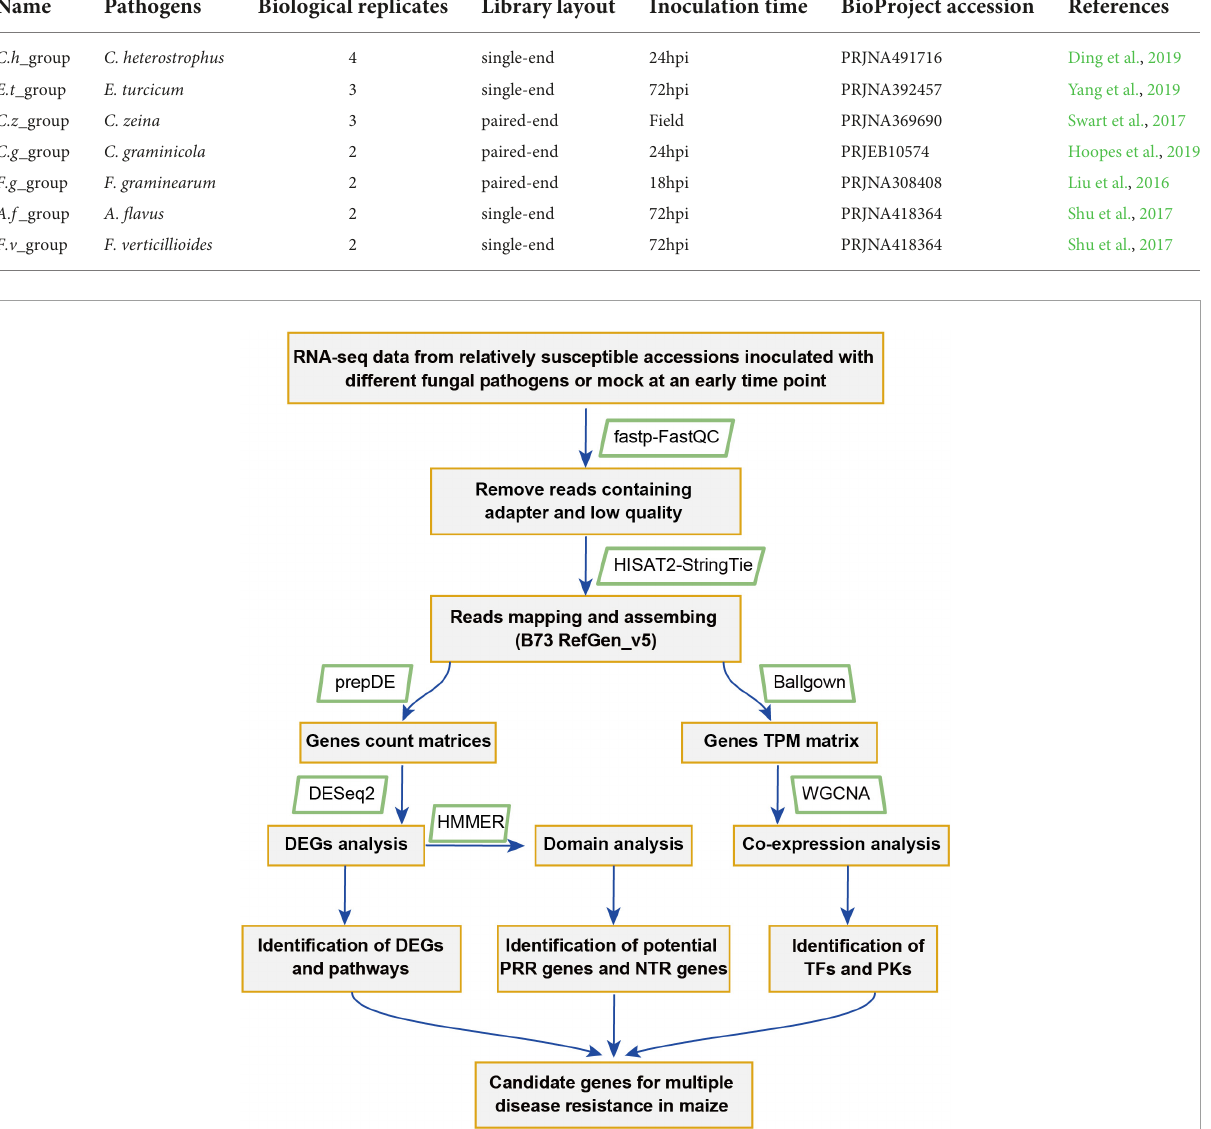
FIGURE1 A flowchart showing the meta-analysis procedure used for the identification of genes and pathways putatively involved in multiple pathogens responses in maize.